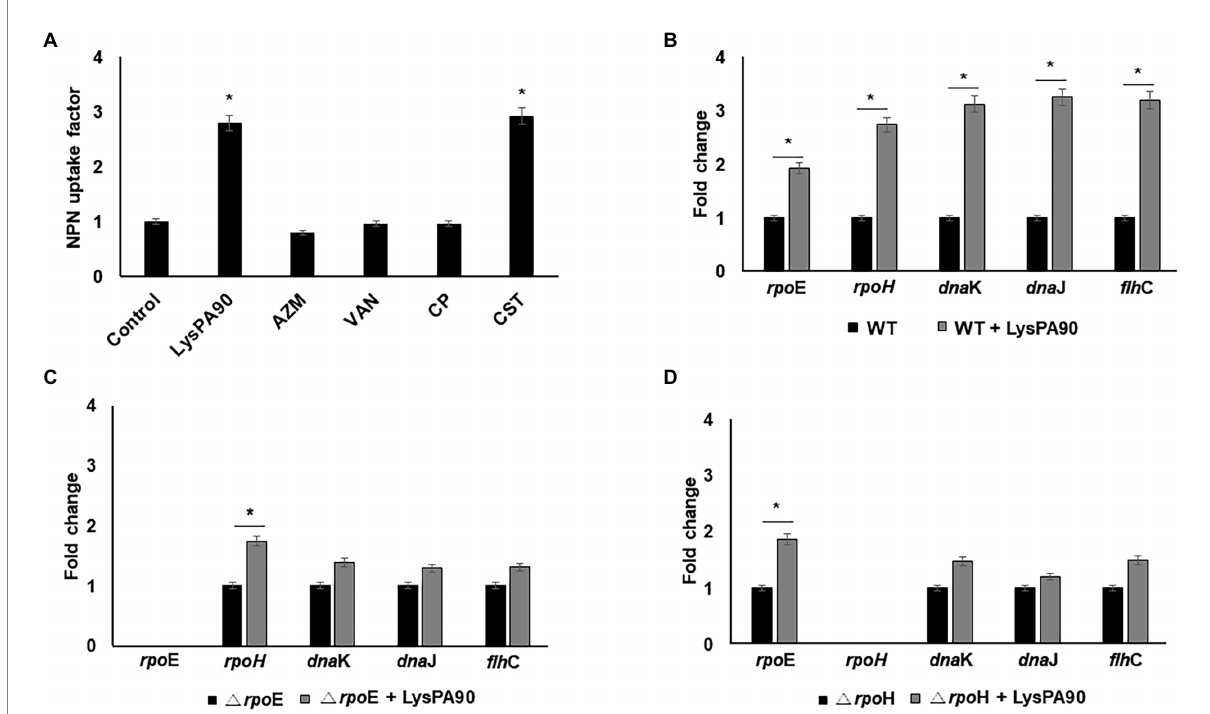
FIGURE 4 Elucidation of a possible mechanism of flagella overexpression. (A) Comparison of NPN uptake of bacteria in the presence of various antibacterials. Control, no antibiotics; LysPA90, endolysin (14.7 μ g/ml); AZM; azithromycin (16 μ g/ml), VAN; vancomycin (128 μ g/ml), CP; chloramphenicol (4 μ g/ml), CST; colistin (0.25 μ g/ml). (B) Realtime RT-PCR analysis of genes involved in membrane stress in either the presence of, or in the absence of LysPA90. (C) Realtime RT-PCR analysis of genes involved in membrane stress from either wildtype or rpo E deletion mutant ( Δ rpo E). (D) Realtime RT-PCR analysis of genes involved in membrane stress from either wildtype or rpo H deletion mutant ( Δ rpo H). Experiments were performed in triplicate. Data are expressed as mean ± standard